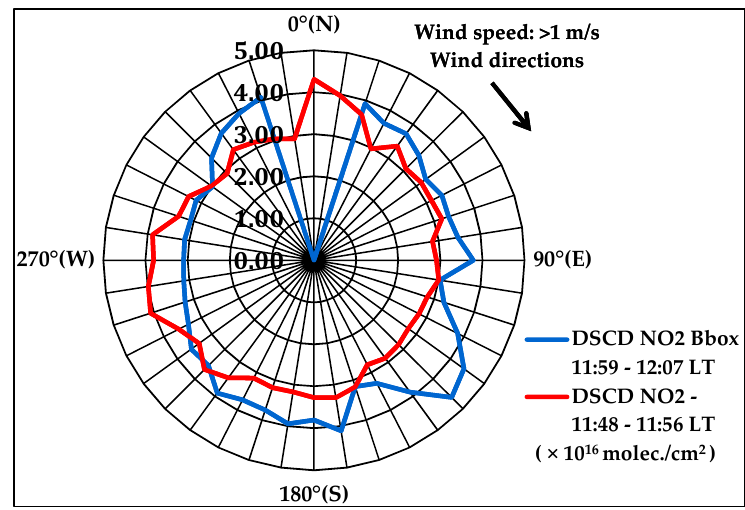
Figure 5. NO 2 DSCD results from 360° HSM and 0° elevation using the UGAL-2D-DOAS system in the black box (BBox) experiment on 11 April 2017. The blue line represents the NO 2 DSCD resulted from the full HSM using BBox as a field of view blocker to the North. The red line corresponds to the NO 2 DSCD resulted from the full HSM performed without the BBox. ×